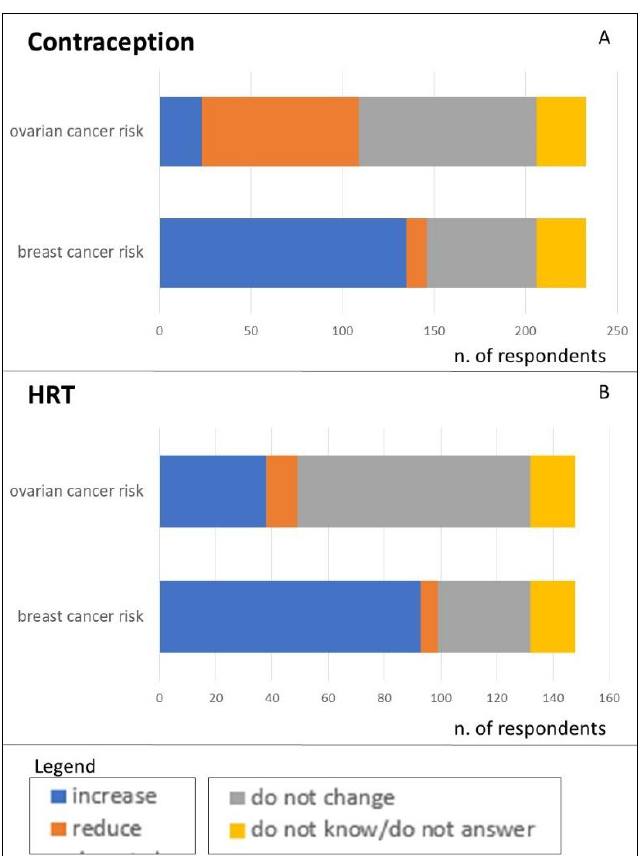
Figure 2. Beliefs of healthy BRCA 1/2 carriers regarding the oncological risk linked to use of contraception ( A ) and hormone replacement therapy (HRT) ( B ). Younger age (OR 0.93, 95% C.I. 0.89–0.97, p = 0.001) and having been reassured